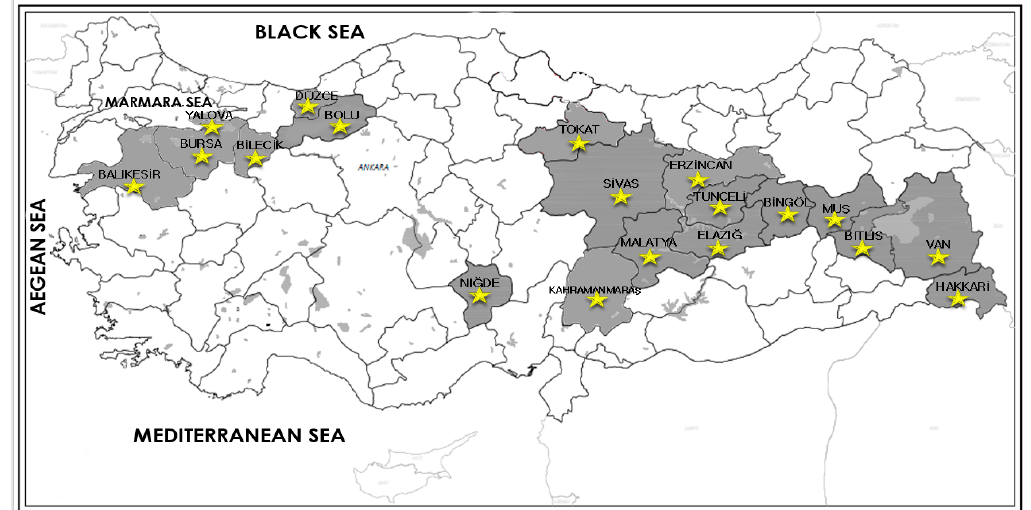
Figure 1. Collection provinces of 183 Turkish common bean accessions.